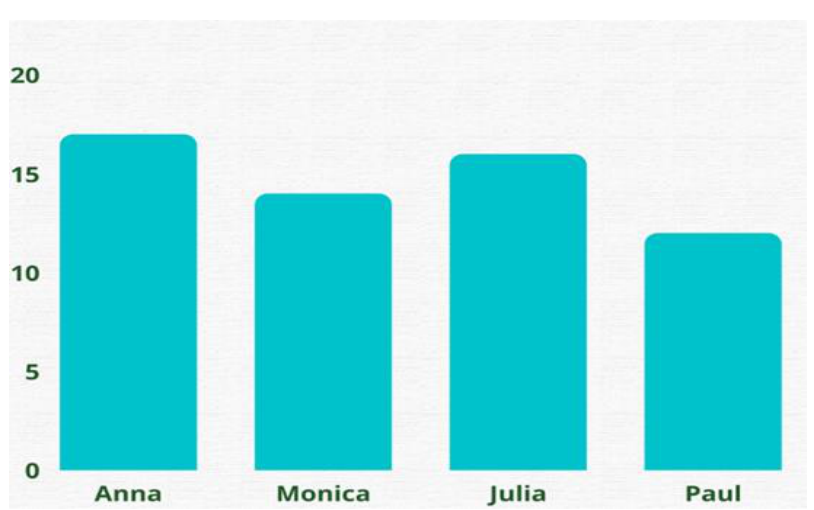
Figure A2. Looking at the Team of Nursing Colleagues You Work in, Which Persona Is Most Recognizable (n = 19)? Note: option to choose more than one answer.